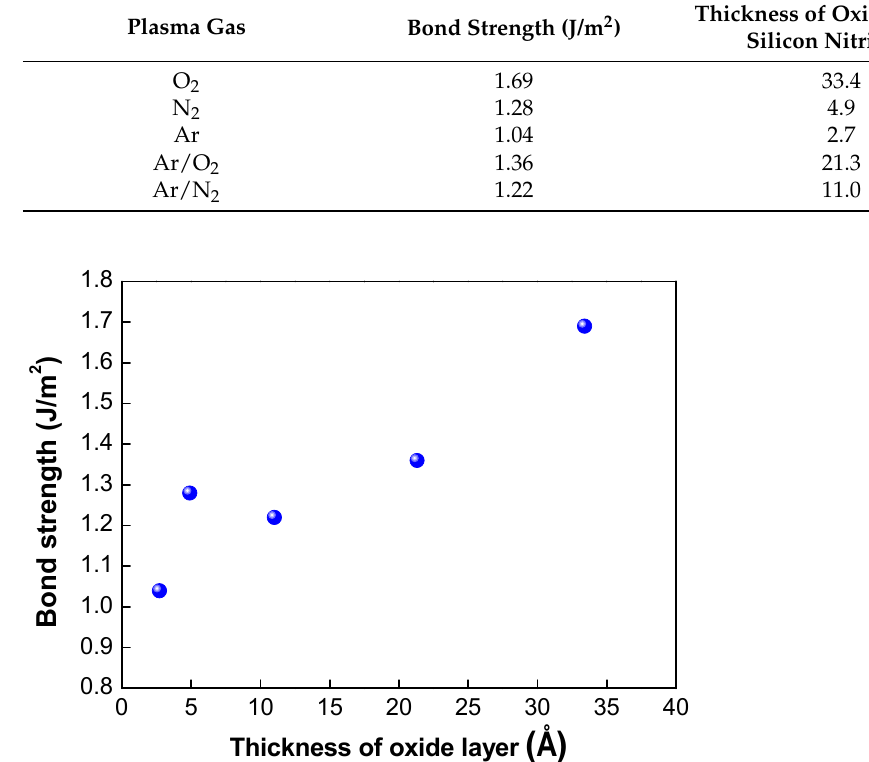
Figure 5. Correlation between thickness of the oxide layer grown on the nitride layer and bond strength.